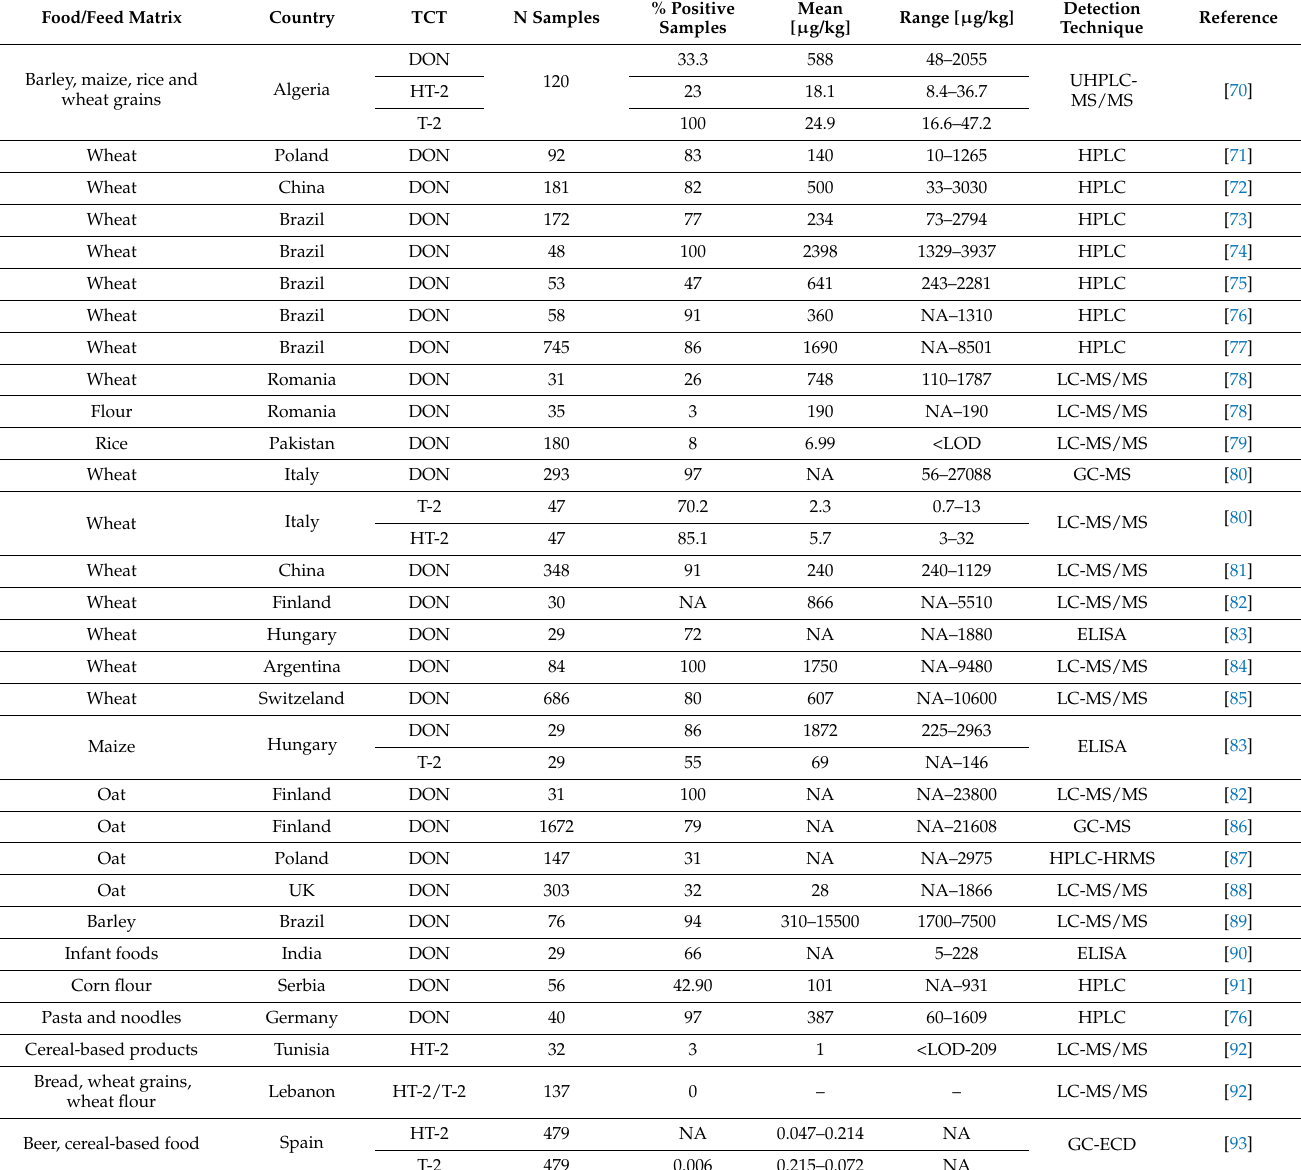
Table 1. Studies on the occurrence of trichothecenes (TCT) distribution ( µ g/kg) in food and feed samples around the world during